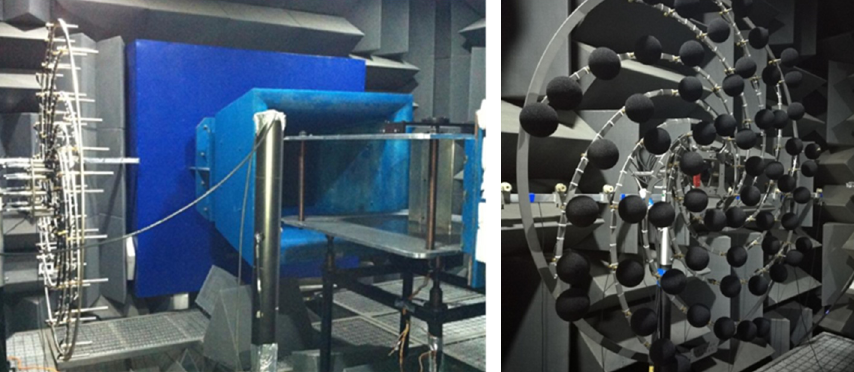
Figure 2. Anechoic wind tunnel and 63-channel phased array for experiment.